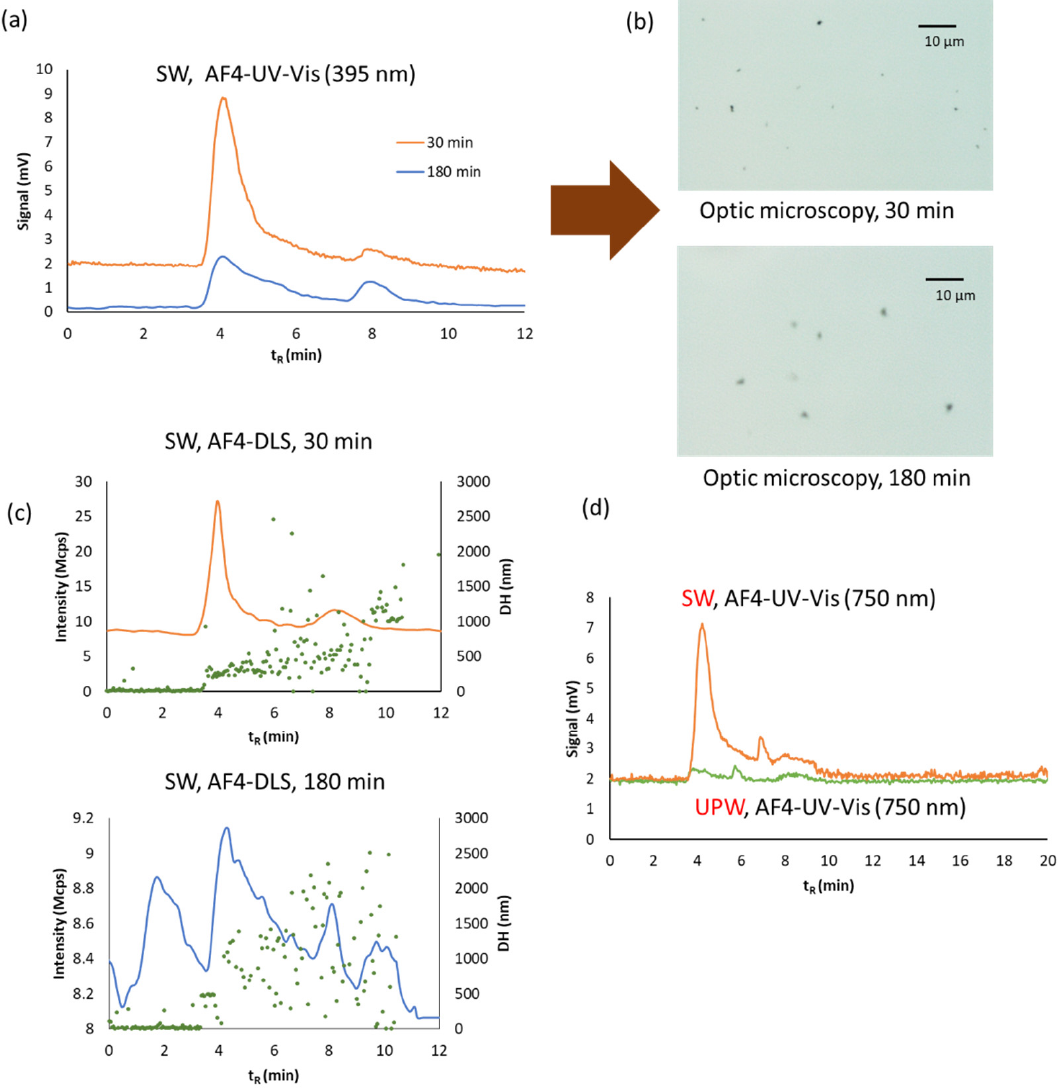
Figure 9. AF4 coupled in series with UV-Vis and DLS detectors for batch O2 diluted 1/4 with sea (SW) water measured at several times: ( a ) fractograms at 395 nm; ( b ) optic images at 30 and 180 min; ( c ) DLS fractograms at 30 and 180 min; ( d ) Fractograms at 750 nm of SW and UPW at 30 min. Crossflow was 0.2 mL·min − 1 .